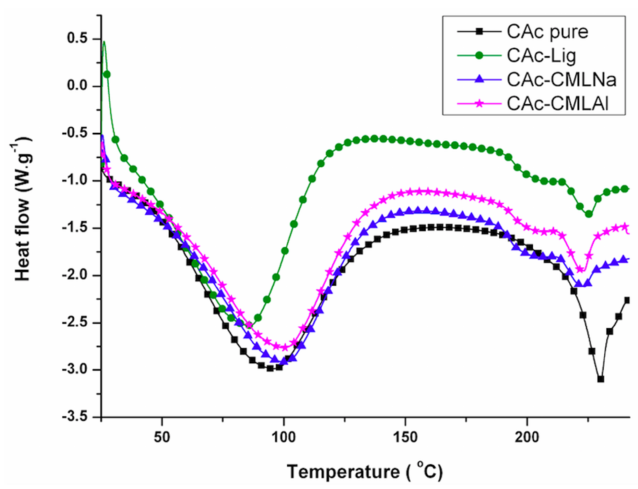
Figure 4. Differential scanning calorimetry (DSC) curves for the membranes of group I.